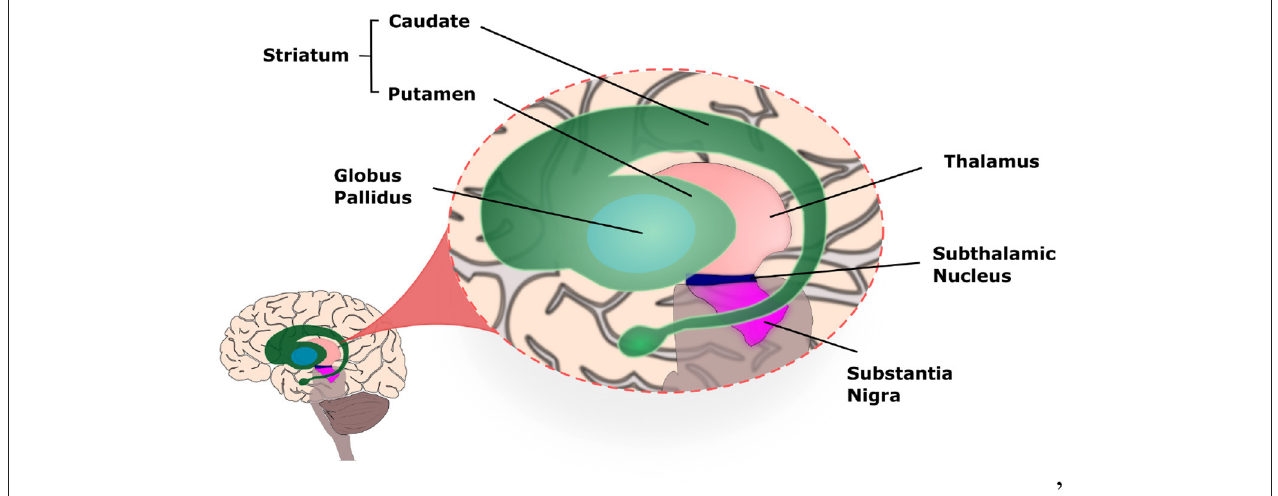
FIGURE 1 | Illustration of the basal ganglia highlighting the location of each nucleus within the human